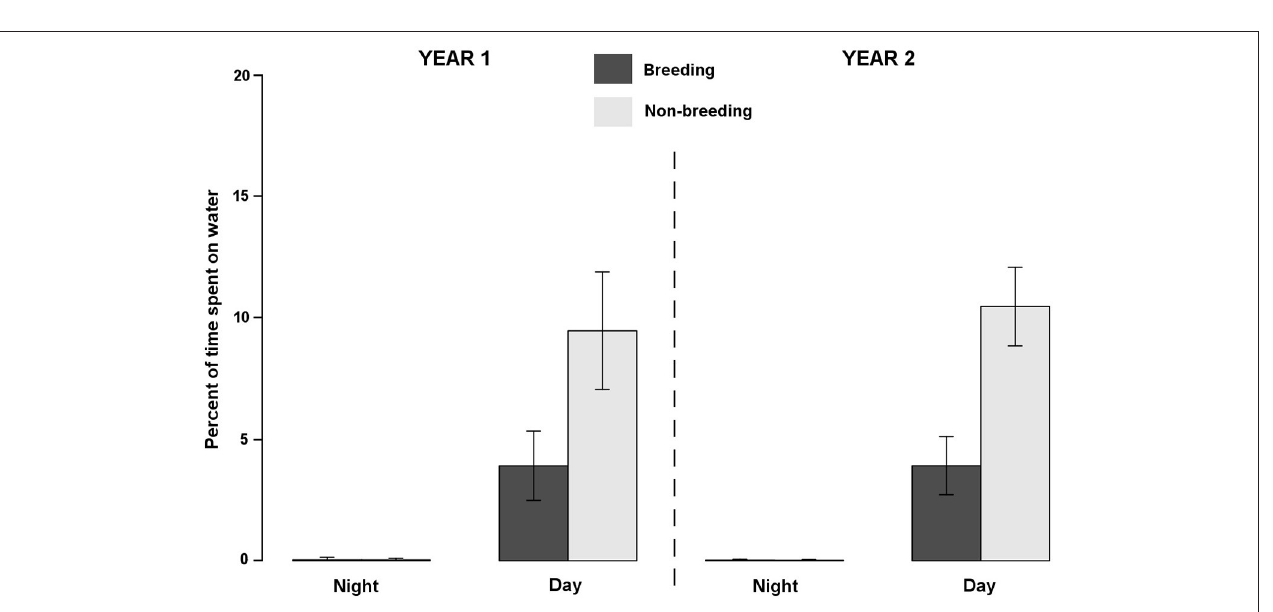
FIGURE 3 | Inter-annual (YEAR1: 2011–2012 and YEAR2: 2012–2013), seasonal (breeding and non-breeding) and diel variations of average ± standard deviation of time spent in contact with the seawater by sooty terns from Bird